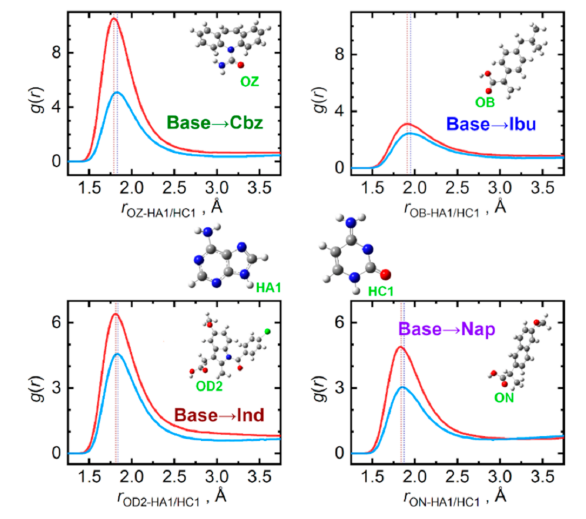
Figure 6. Hydrogen bonding between API (hydrogen acceptor) and nucleobase (hydrogen donor) molecules in the liquid phase at 410 K. Radial distribution functions are given for the most significant contacts in equimolar mixtures of API with adenine (light blue) and cytosine